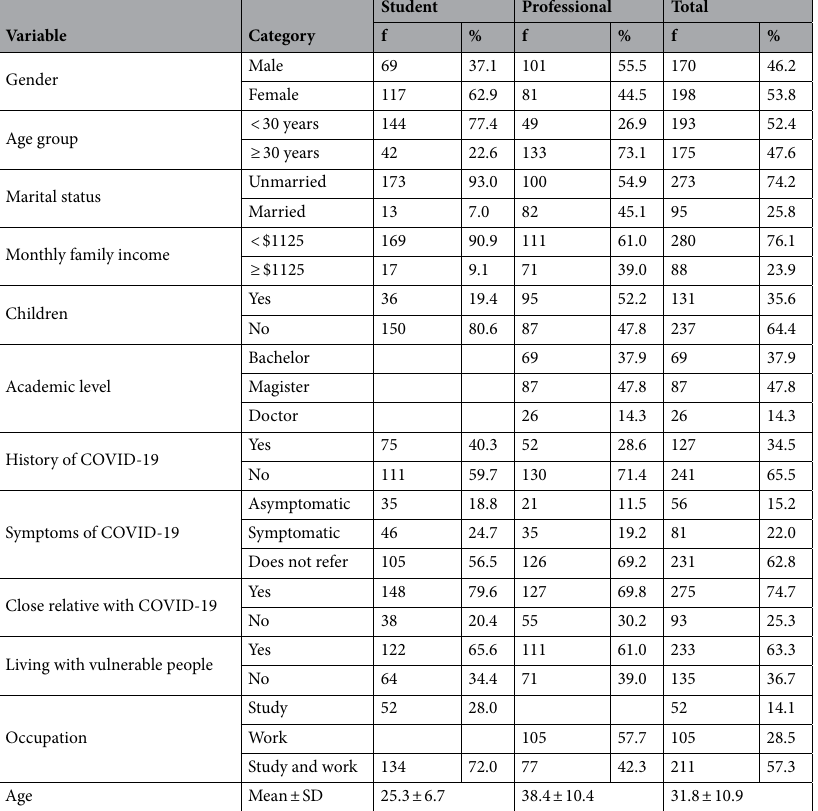
Table 1. Characterization of sociodemographic variables in dental students and professionals in a Lima population during the second wave of COVID-19. f absolute frequency, SD standard